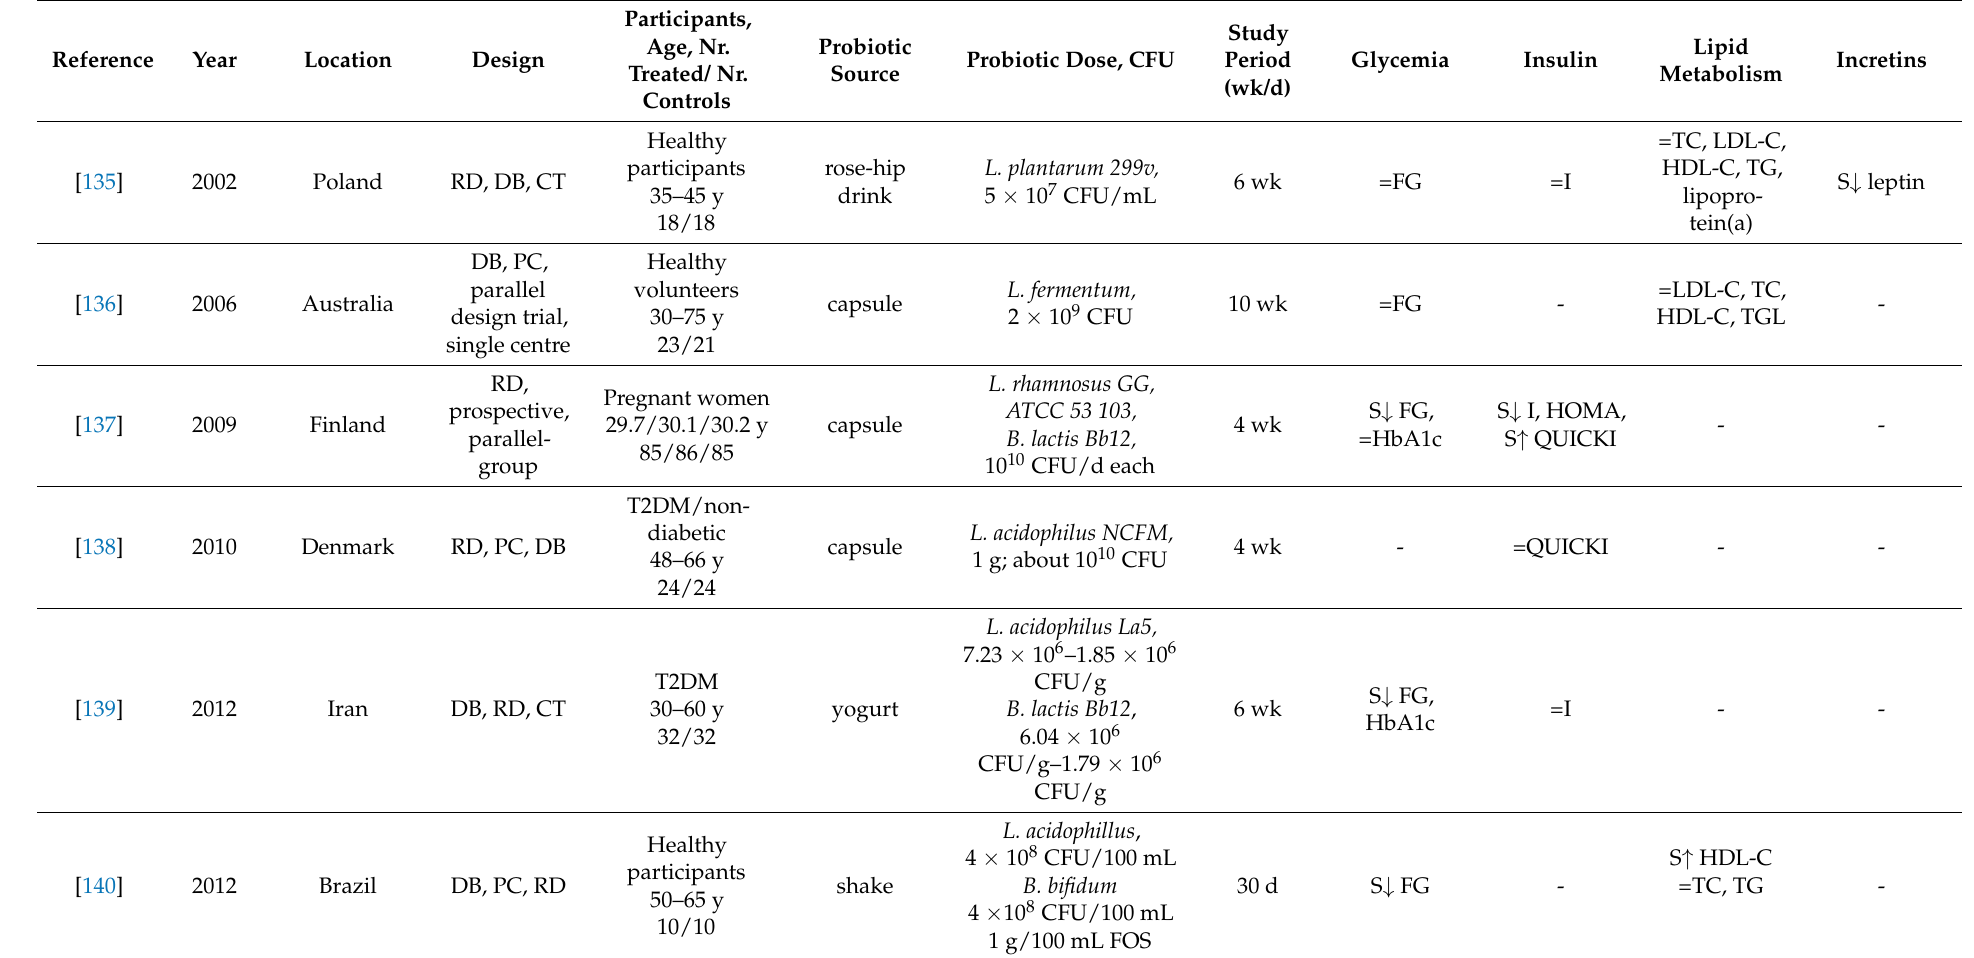
Table 2. Effects of probiotic or synbiotic on glycemia, insulin, lipid metabolism and